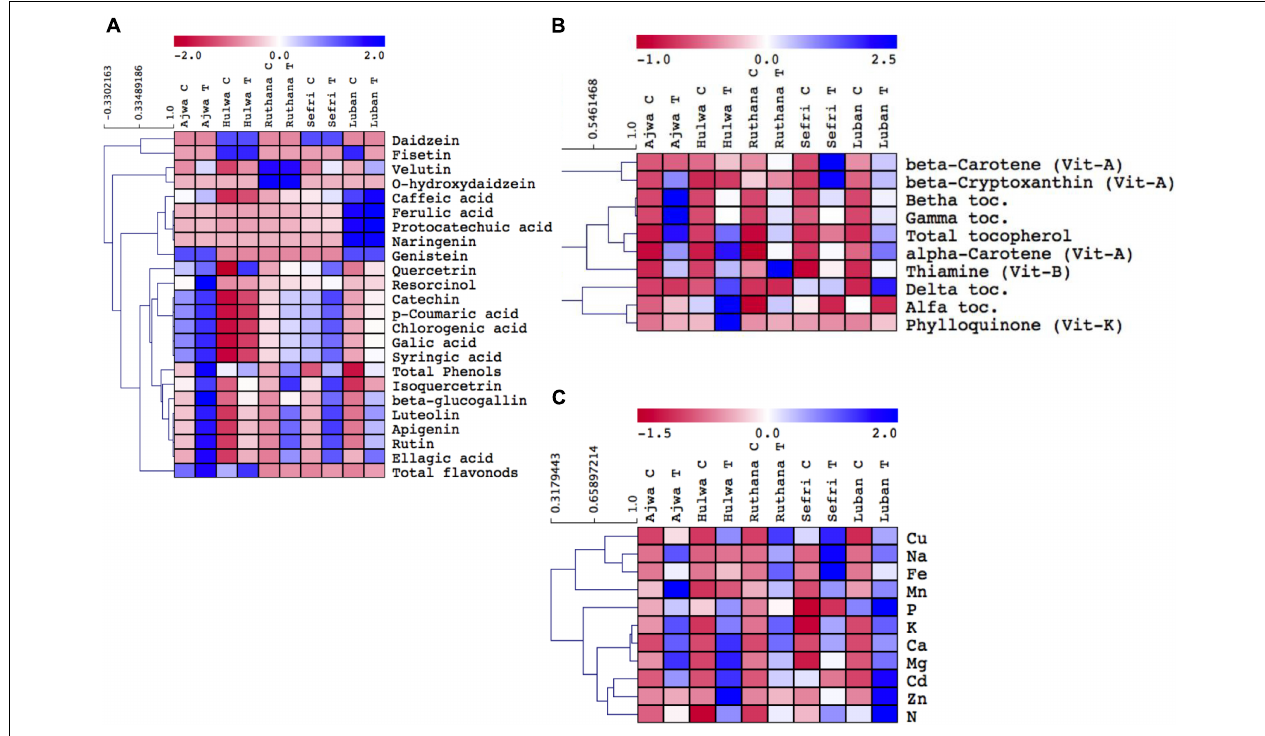
FIGURE 2 | Hierarchical clustering of phenolics and flavonoids (A) , vitamin (B) , and mineral (C) concentrations in vermicompost-fertilized and non-fertilized P. dactylifera cv. Ajwa, Hulwa, Ruthana, Sefri, and Luban fruits. Vermicompost fertilization was carried out at a rate of 10 Kg/tree and fruits were harvested at the tamar